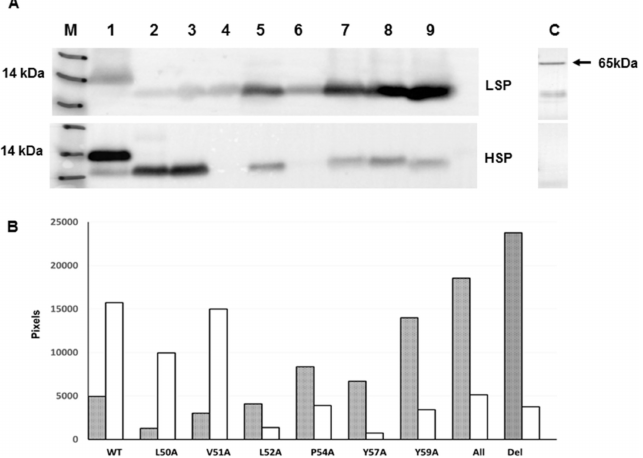
Figure5. WesternblotAnalysisofWTMHV-Eandmutantsfollowingmembranepartitionbydi ff erential centrifugation. ( A ) Detection of E protein by anti-His antibody in the low- and high-speed membrane fractions (marked). Lane M - See Blue ™ Plus2 Pre-Stained Protein Standard (Invitrogen) with